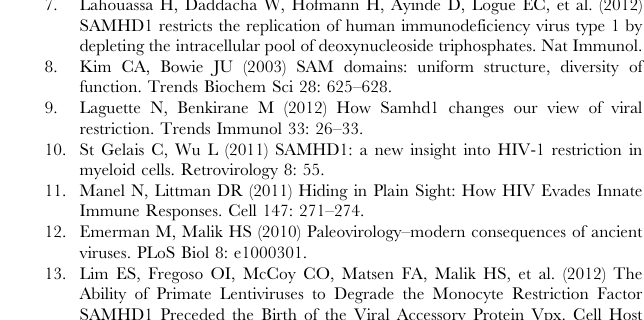
Figure S1 Pairwise comparisons of dN and dS among seven primate SAMHD1 sequences. The red arrow indicates the data point with dN/dS . 1. Figure S2 The amino acid mutations fixed by orangutan SAMHD1 sequence. The green shadows indicate the amino acid mutations were detected to be under positive selection by PAML 4.2. The SAM and HD domains are highlighted by the blue and pink frames, respectively. The sequences corresponding to the gap sequences in rhesus macaque and marmoset SAMHD1 (see Fig. 5) were excluded from the analysis. Figure S3 Maximum likelihood tree of vpx genes from SIV and HIV-2. SIVcpz/gor and HIV-1 group M that lost the vpx genes were merged into the tree based on the topology of pol gene tree (Figure 3). Because the Vpx of two SIVrcm isolates from Nigeria and Gabon cannot degrade human SAMHD1 [3], we